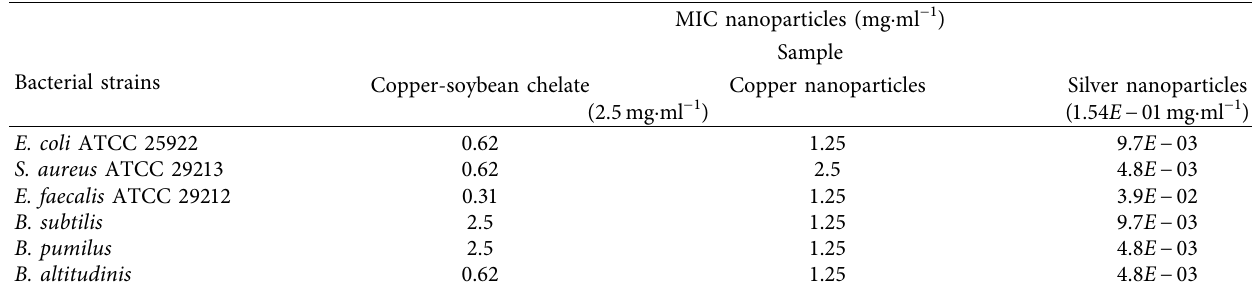
Figure 6: Infrared absorption spectra of copper-soybean chelate solution. Table 1: Minimum inhibitory concentration